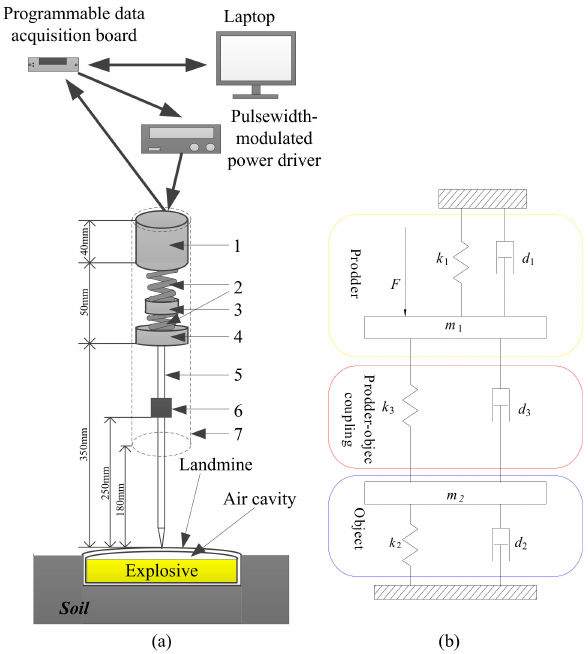
Figure 1. ( a ) Mechanical sketches of the sensorized prodder; ( b ) Kinetic model of “prodder-object”